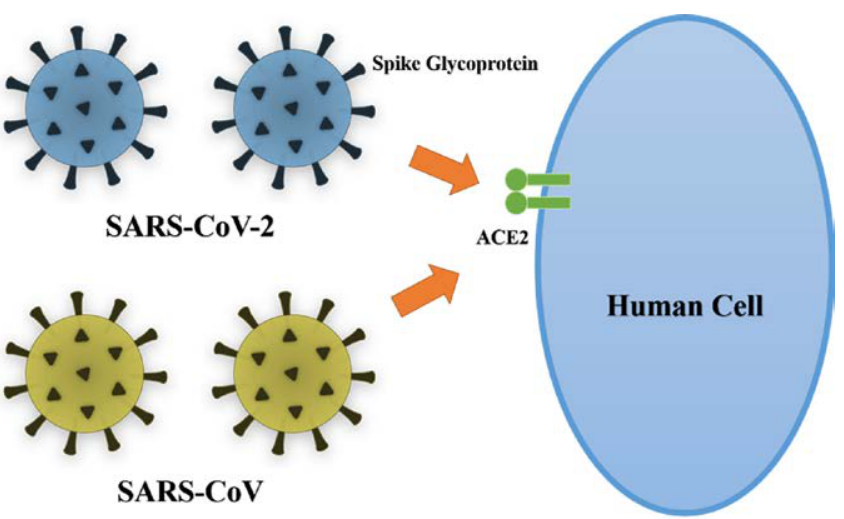
Fig. 1. Schematic diagram of SARS-COV and SARS-CoV-2 binding with high affinity to ACE2, an essential step in viral entry into host